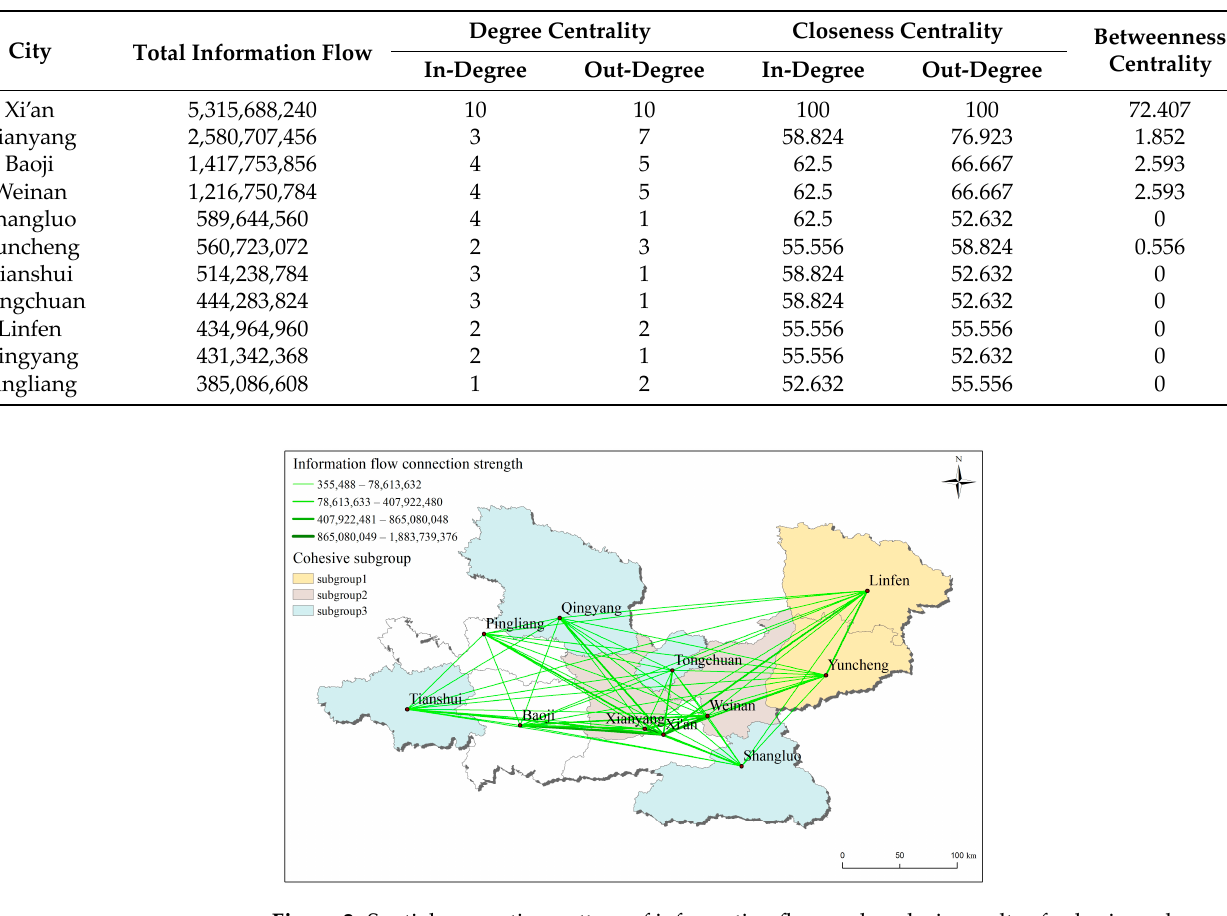
Table 1. Total information flow and centrality.